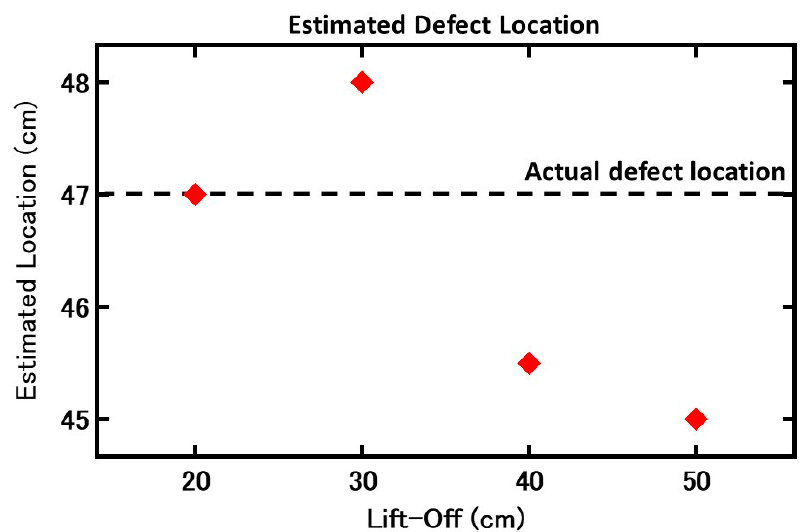
Figure 7. Estimated defect location based on the results. A loss in accuracy occurs as lift-off increases.